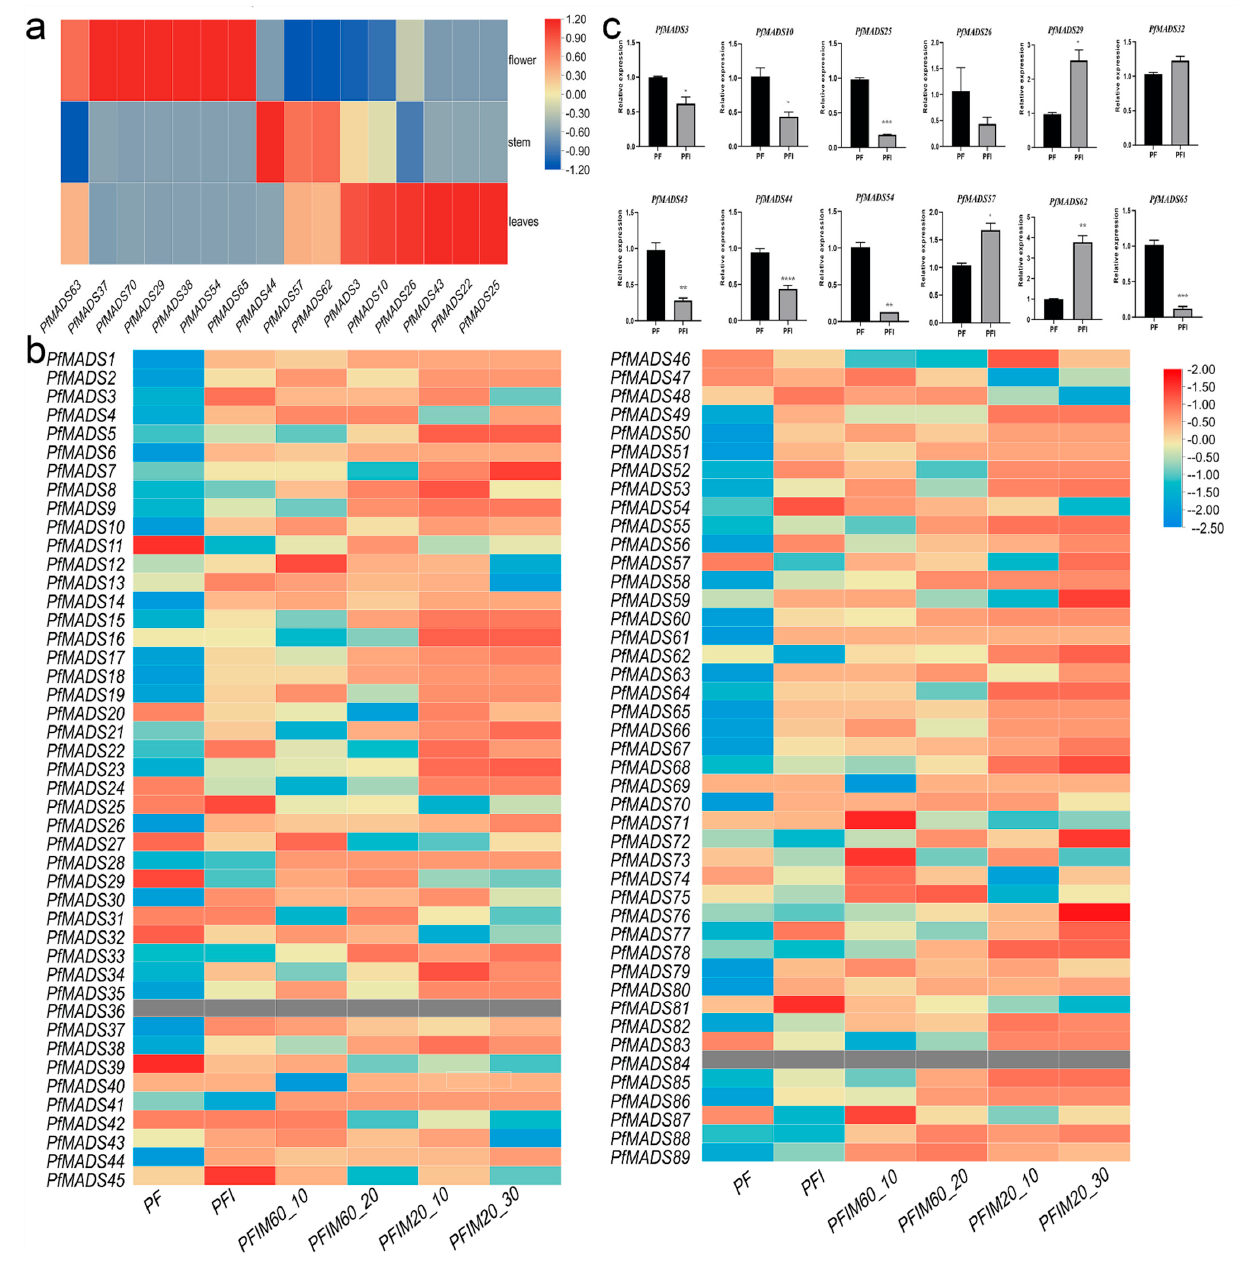
Figure 6. Expression pattern analysis of PfMADS-box genes. ( a ) heat map of PfMADS-box genes in PF, PFI, and MMS-treated PFI seedlings. PFIM60-10: PFI treated with 60 mg·L − 1 MMS for 10 days; PFIM60-20: PFI treated with 60 mg · L − 1 MMS for 20 days; PFIM20-10: PFI treated with 20 mg · L − 1 MMS for 10 days; PFIM20-30: PFI treated with 20 mg · L − 1 MMS for 30 days. ( b ) Expression levels of several PfMADS-box genes in different tissues. ( c ) Results of qRT-PCR validation. Values are means ± SD ( n = 3). Asterisks indicate a significant difference (** p < 0.01; * p < 0.05).